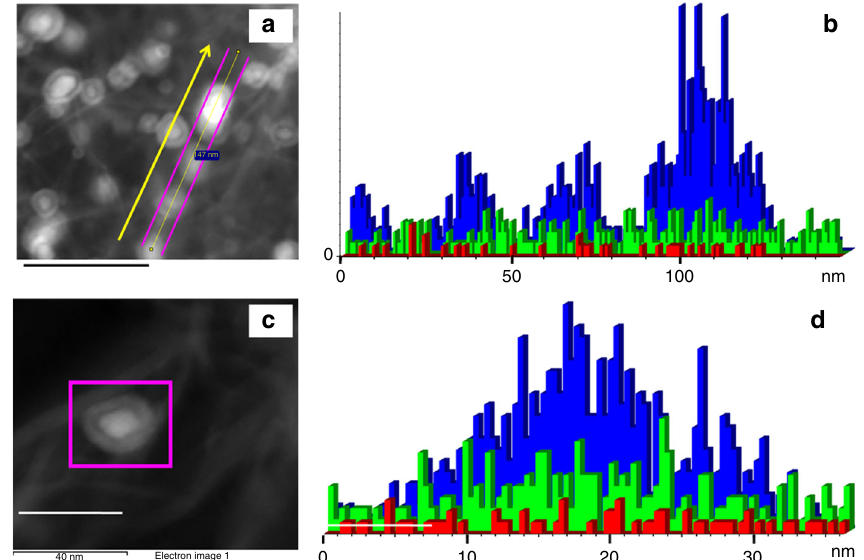
Fig. 4 Scanning transmission electron microscope (STEM) images of Fe-L 1 @EGO-900. a STEM image of Fe-L 1 @EGO-900 catalyst. b Line pro fi le of iron (blue), oxygen (green), and nitrogen (red) passing through the line. c STEM image of single particle. d Line pro fi le of single iron nanoparticle iron (blue), oxygen (green), and nitrogen (red) passing through the particle. Scale bar is 40